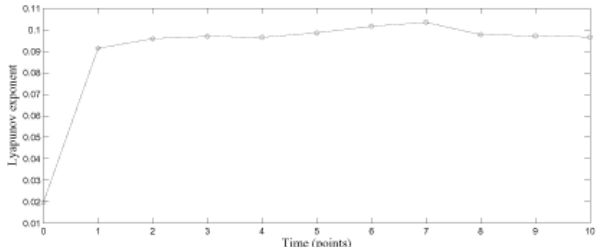
Fig. 6. Lyapunov exponent and its evolution, computed as the state space trajectory with τ = 30, and m = 5 for detrended time series measured at Lagos with the largest Lyapunov exponent equal to 0.1035.